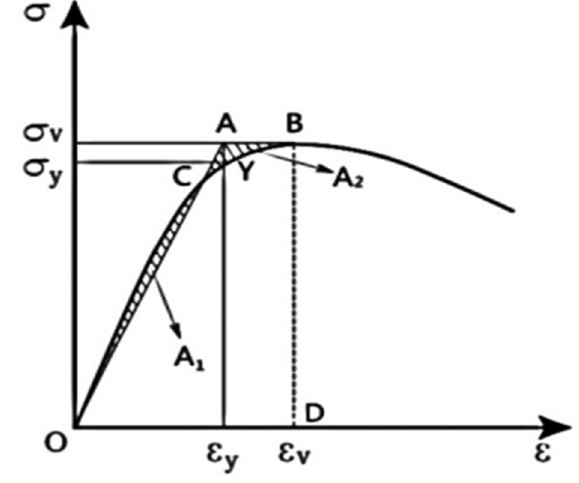
Figure 25. Isoenergetic method to find the yield strength. Table 7. Ductility factor.